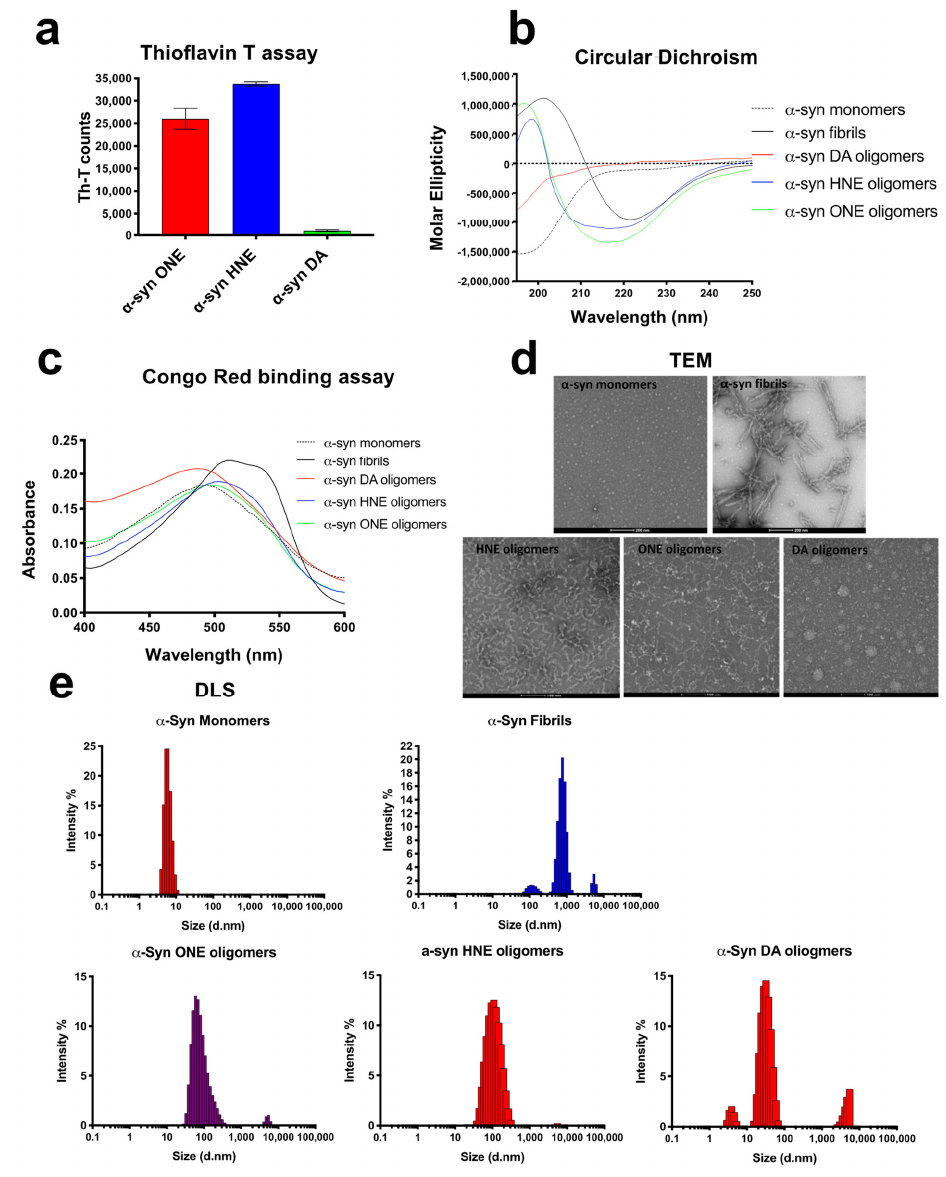
Figure 2. Biophysical characterization of α-syn oligomers. ( a ) Th-T assay: 5 μM α-syn oligomers were mixed with 20 μM Th-T. ( b ) Circular dichroism using 5 μM of α-syn monomers, fibrils, and different oligomers ( c ) Congo red binding assay: 5 μM α-syn monomers, fibrils, or oligomers were mixed and incubated with 20 μM of Congo red dye for 30 min and absorbance measured between 400 and 600 nm. ( d ) Negatively stained TEM images of α-syn monomers, fibrils (100 nm), and oli- gomers (scale bars, 200 nm). ( e ) Dynamic light scattering using 5 μM α-syn monomers, fibrils, and oligomers expressed as intensity with hydrodynamic diameter on the x axis.